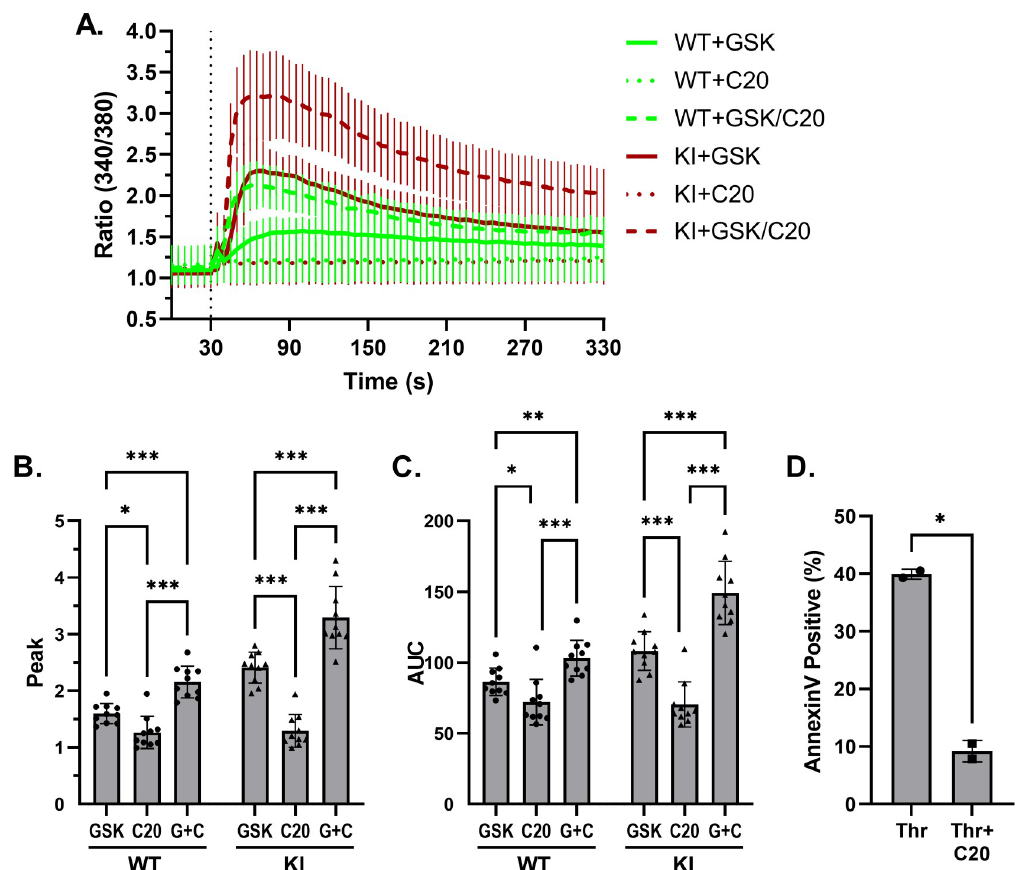
Fig 6. TRPC6-PAM-C20 enhances wild-type and mutant TRPC6-mediated calcium influx. A, Fura-2 fluorescence ratio (340/380) time-course in WT and KI platelets stimulated with the indicated combinations of C20 (10 μ M) and GSK (50 μ M) after 30 seconds; n = 10 using platelets from 5 mice per genotype. The post-stimulation Fura-2 fluorescence ratio peak (B), and area under the curve (C) are shown; two way ANOVA with Tukey’s multiple comparisons test. D, percentage of DN platelets staining with Annexin V after being stimulated with thrombin (Thr) or thrombin plus C20; n = 2 per group; paired